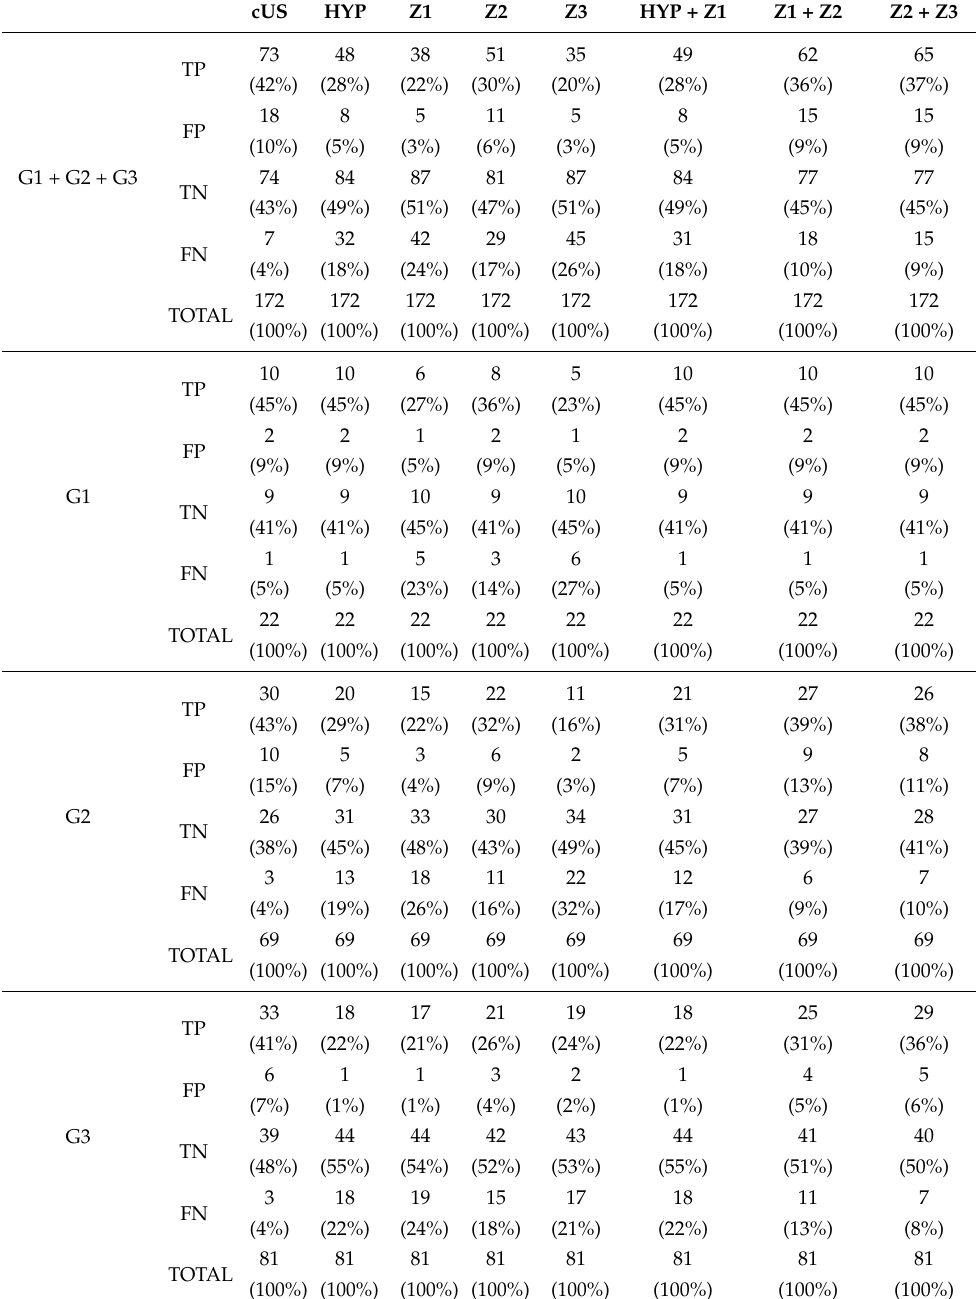
Table 2. Ultrasonography findings with each scan windows for each